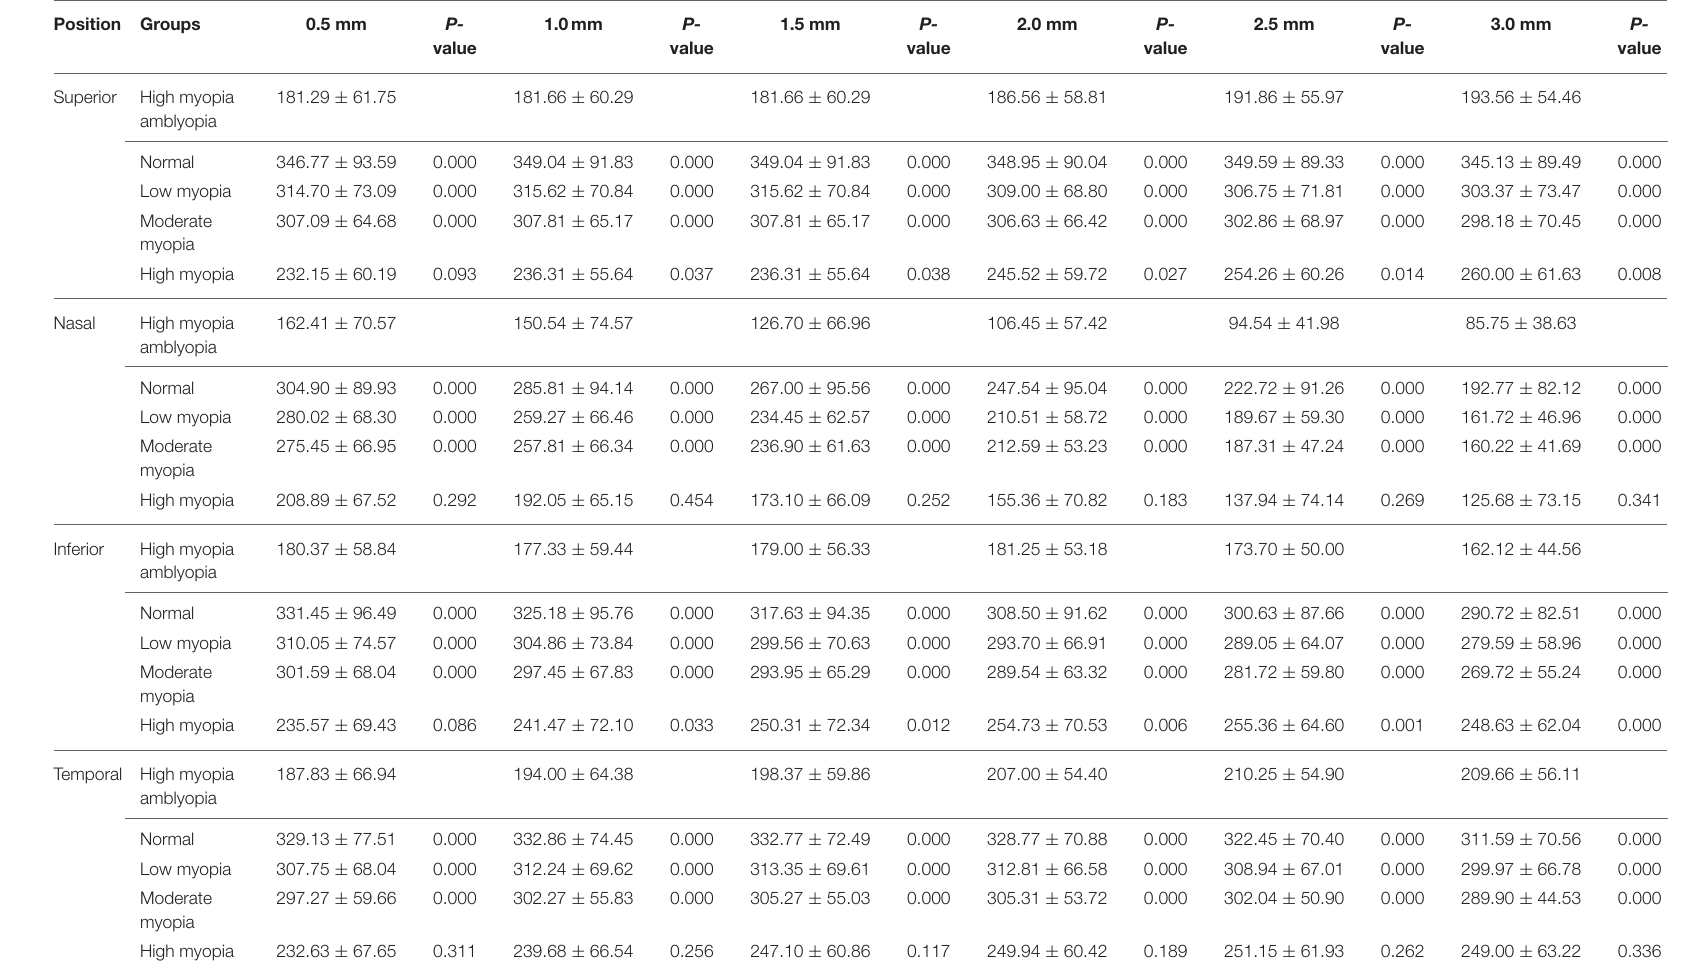
TABLE 4 | Choroidal thickness in each